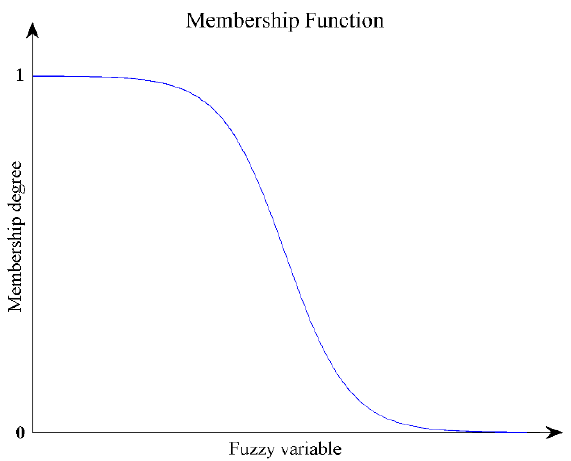
Figure 4. Z-type membership function.